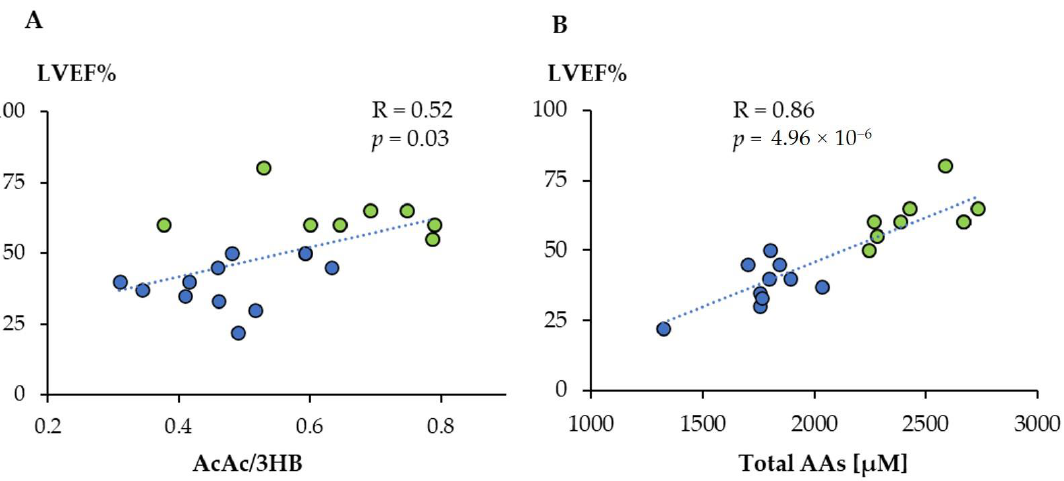
Figure 5. Linear correlation between acetoacetate/3-hydroxybutyrate ratio (AcAc/3HB) ( A ) and total amino acids concen- tration ( B ) with LVEF%. Green dots: controls; blue dots: